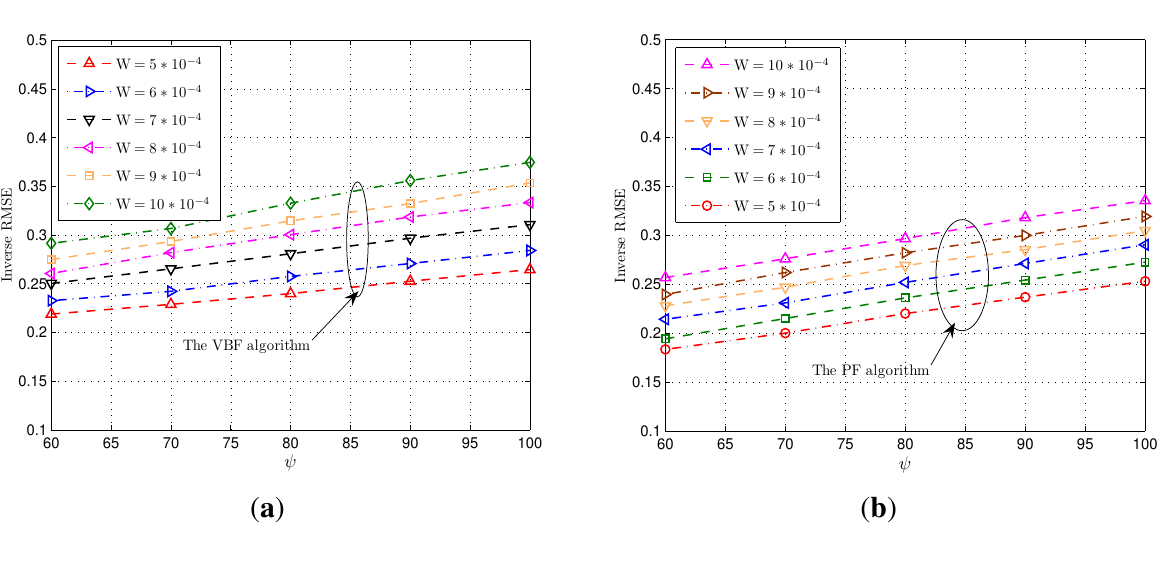
Figure 6. Tracking accuracy over different precision expectations. The y -axis is in meters. ( a ) Accuracies achieved by the VBF algorithm over different levels of deep shadow fading; ( b ) accuracies achieved by the PF algorithm over different levels of deep shadow fading.